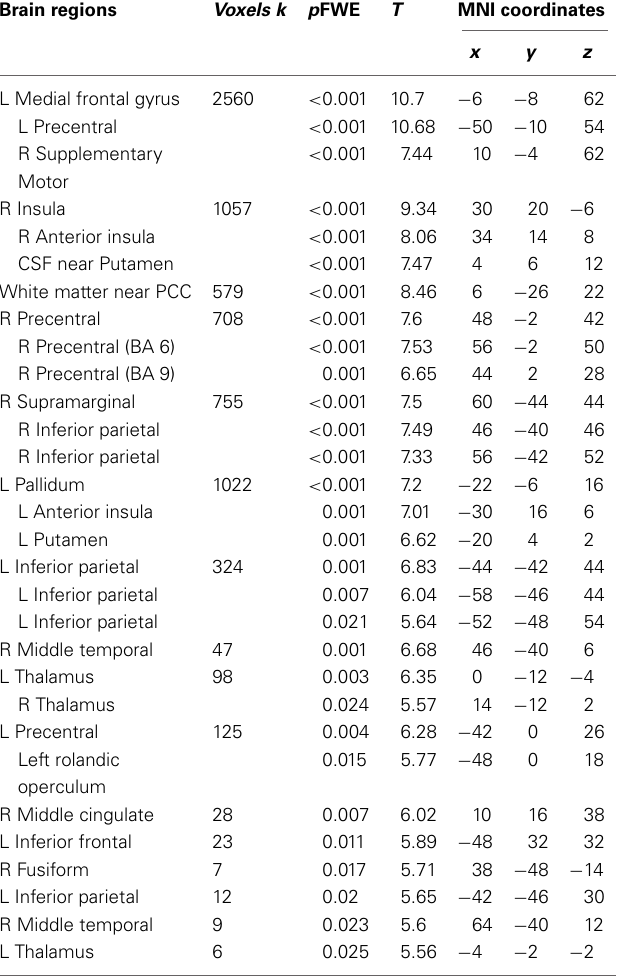
Table 3 | Brain regions displaying significant BOLD activations for correct stop trials compared to baseline.